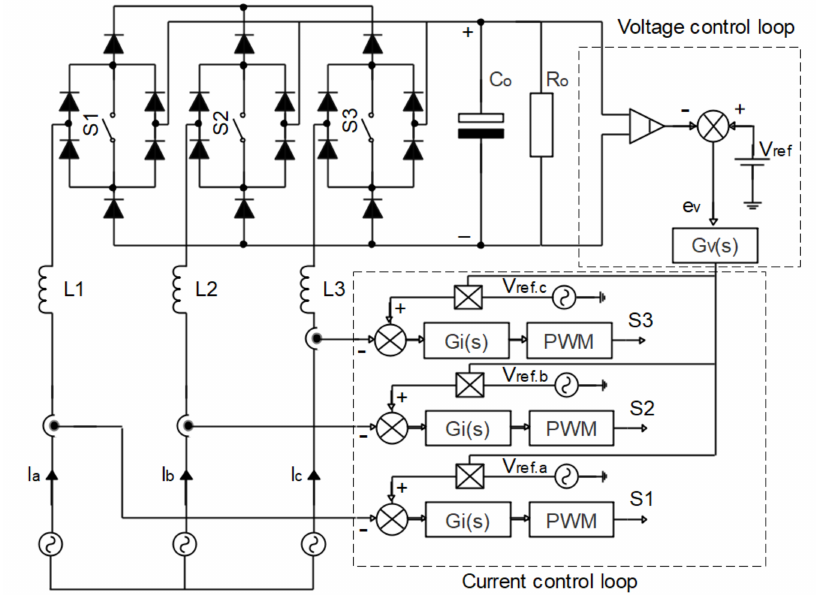
Figure 8. VIENNA rectifier with PFC and respective control system. BOOST-type PWM bidirectional three-phase rectifier: It is widely used when good sinusoidal currents are desired. This structure also has an inductor in each phase and is controlled by six power switches, as shown in Figure 9. Control is also given by two loops: the voltage loop and the current loop. The voltage loop and reference signal process that goes to the current compensator ( G ) is basically the same as that described in the i ( S ) VIENNA rectifier. In this case, each current compensator ( G ) with the PWM modulator i ( S ) generates two port signals suitable for the rectifier system [26,34].